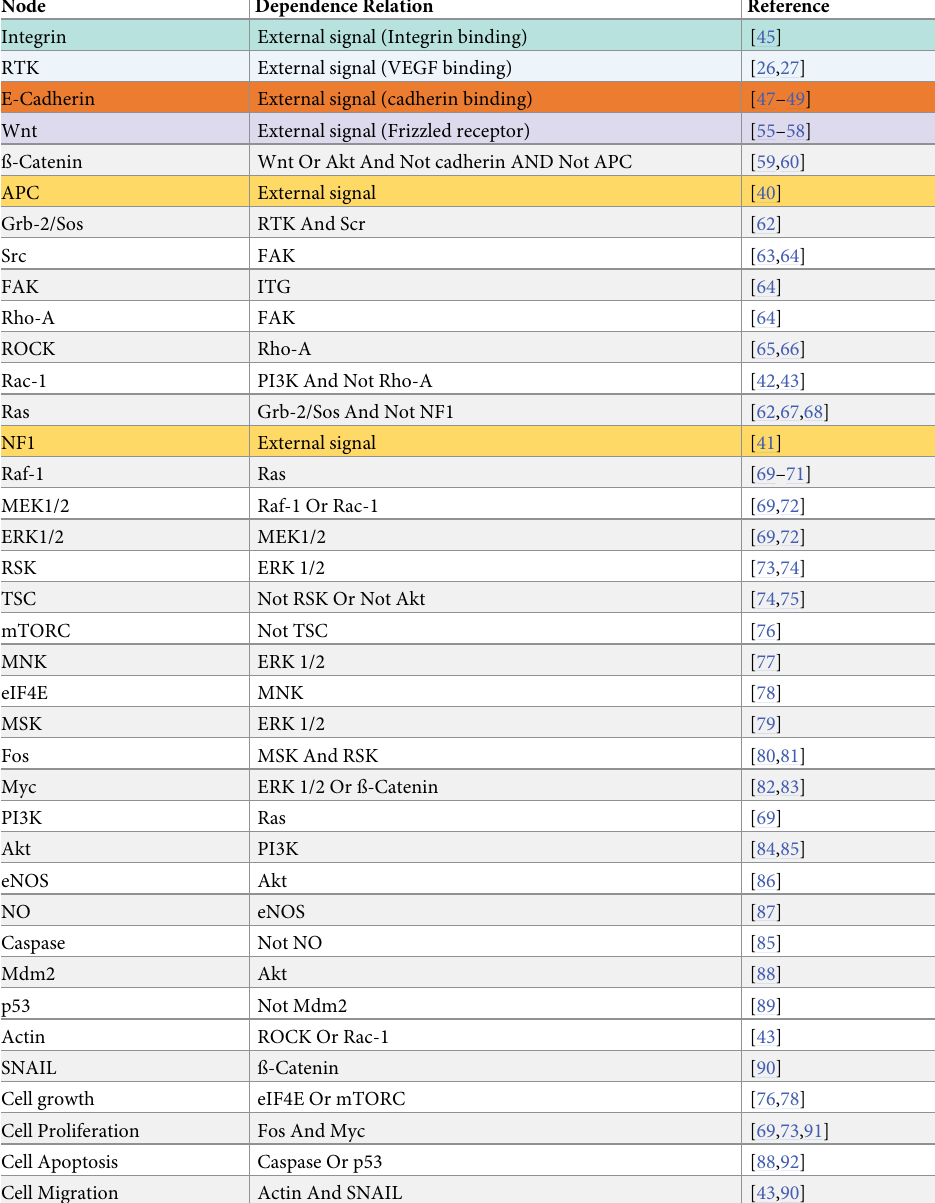
Table 1. Boolean dependence relations between molecules of the signaling cascades presented in Fig 2, and the corresponding